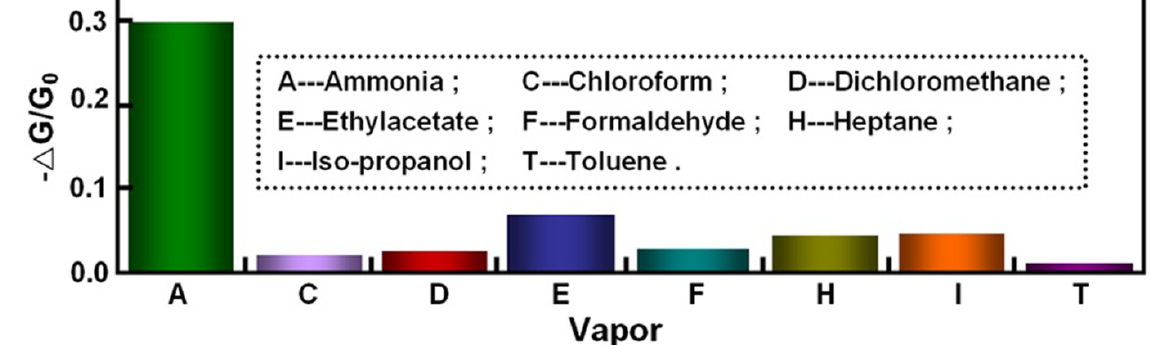
Figure 14. Selectivity tests of gas sensors based on NiO films. The concentration of NH 3 is 50 ppm, and the concentration of other organic gases is higher than 300 ppm